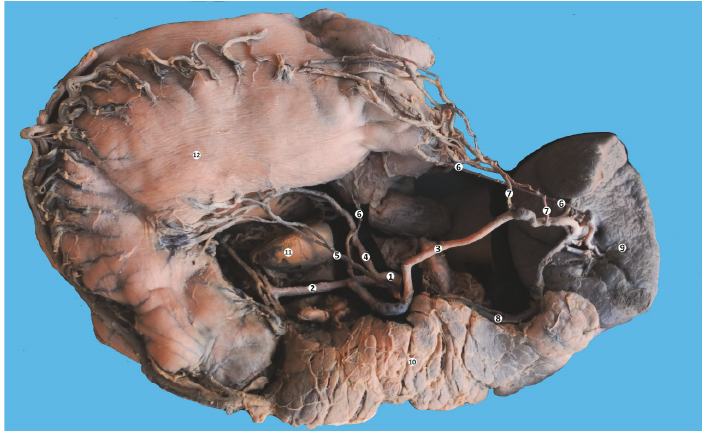
Figure 1: The branches of the celiac trunk. Macrospecimen (female, 63 years old). 1: celiac trunk, 2: common hepatic artery, 3: splenic artery, 4: left gastric artery,5: accessoryleft gastric artery,6: posterior gastric artery,7: left gastroepiploic artery 8: splenic vein, 9: spleen, 10: pancreas, 11: caudate lobe of the liver, and 12: stomach.